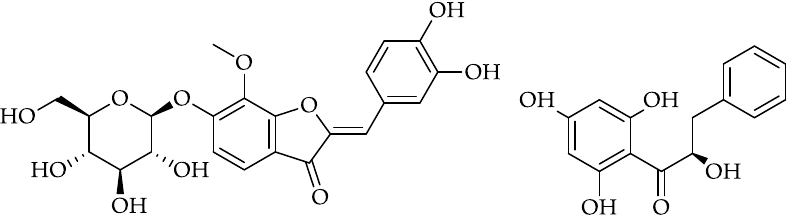
Figure 13. Structure of leptosin ( 88 , Table 8) and of pinobanksin chalcone ( 89 , Table 8). Table 8. Aurones and chalcones reported in monofloral honeys.